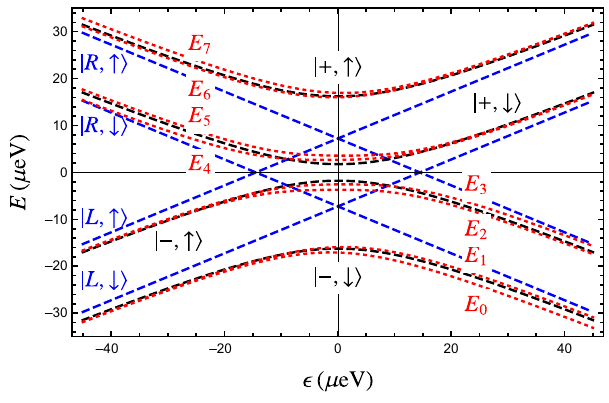
FIG. 2. Energy spectrum of the QD-donor Hamiltonian (cid:2) H 0 as a function of the QD-donor detuning parameter (cid:2) for B z = 14.5 μ eV. The dashed blue lines show the energy levels for t c = b x = 0 with the corresponding eigenstates denoted by the electronic position in the QD-donor system, L and R , and its spin projection ( ↓ / ↑ ) along the z axis. Switching on the tunnel cou- pling t c (here t c = 9 μ eV) mixes the L and R states with the same spin resulting in the bonding ( − ) and antibonding ( + ) molecu- lar orbital states, whose energies are given by the dashed black lines. Finally, the dotted red energy levels include the hyperfine coupling to the nuclear spin (eigenenergies E 0 , . . . , E 7 of (cid:2) H sys ). For this plot, we have used exaggerated values b x = 5 μ eV and A = 1 GHz to emphasize the effects of the magnetic field gradient and the hyperfine